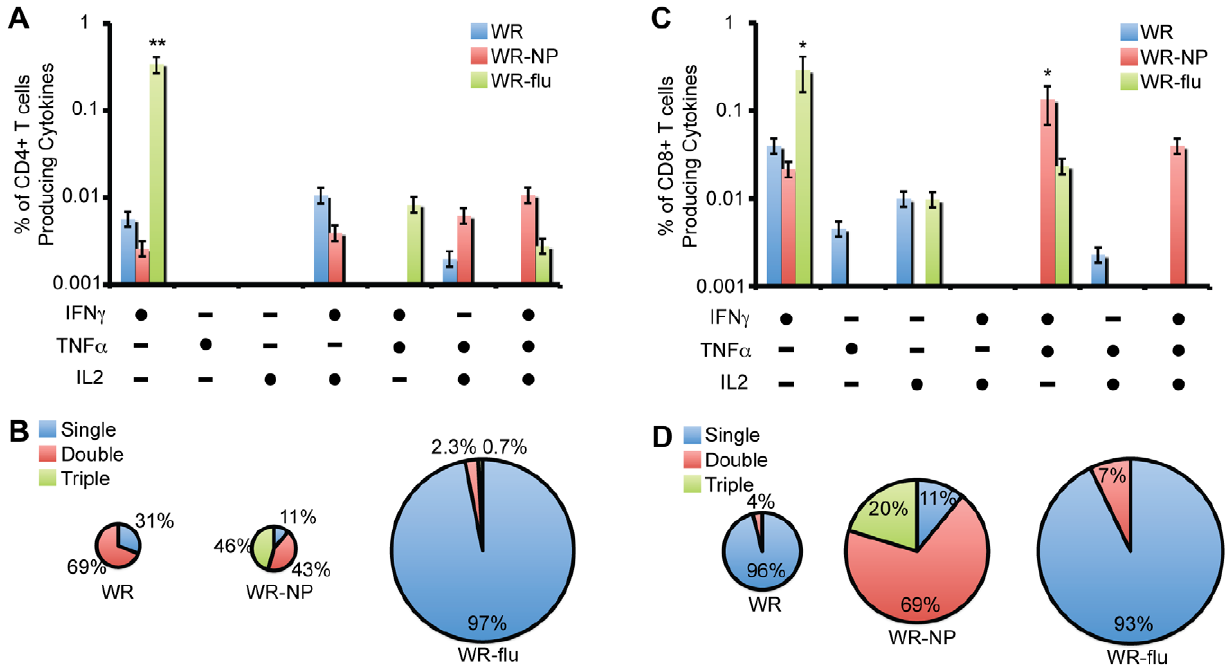
Figure 6. Polyfunctionality of influenza virus-specific CD4 + and CD8 + T cells. (A, C) Functional composition of CD4 + (A) or CD8 + (C) T cells responses against influenza virus NP peptide based on the secretion of IFN c , IL-2, or TNF a . All the possible combinations of the responses are shown on the x-axis, whereas the percentages of the functionally distinct cell populations are shown on the y-axis. Bars correspond to the fraction of different functionally distinct T-cell populations within total CD4 + or CD8 + populations. Responses are grouped and color-coded on the basis of the number functions. (*, P , 10 2 5 ; **, P , 10 2 25 ) (B, D) The pie chart summarizes the data and each slice of the pie correspond to the fraction of CD4 + T cells with a given number of functions within the total CD4 + (B) or CD8 + (D) T cell populations. The size of the pie chart represents the magnitude of the specific influenza virus immune response induced.